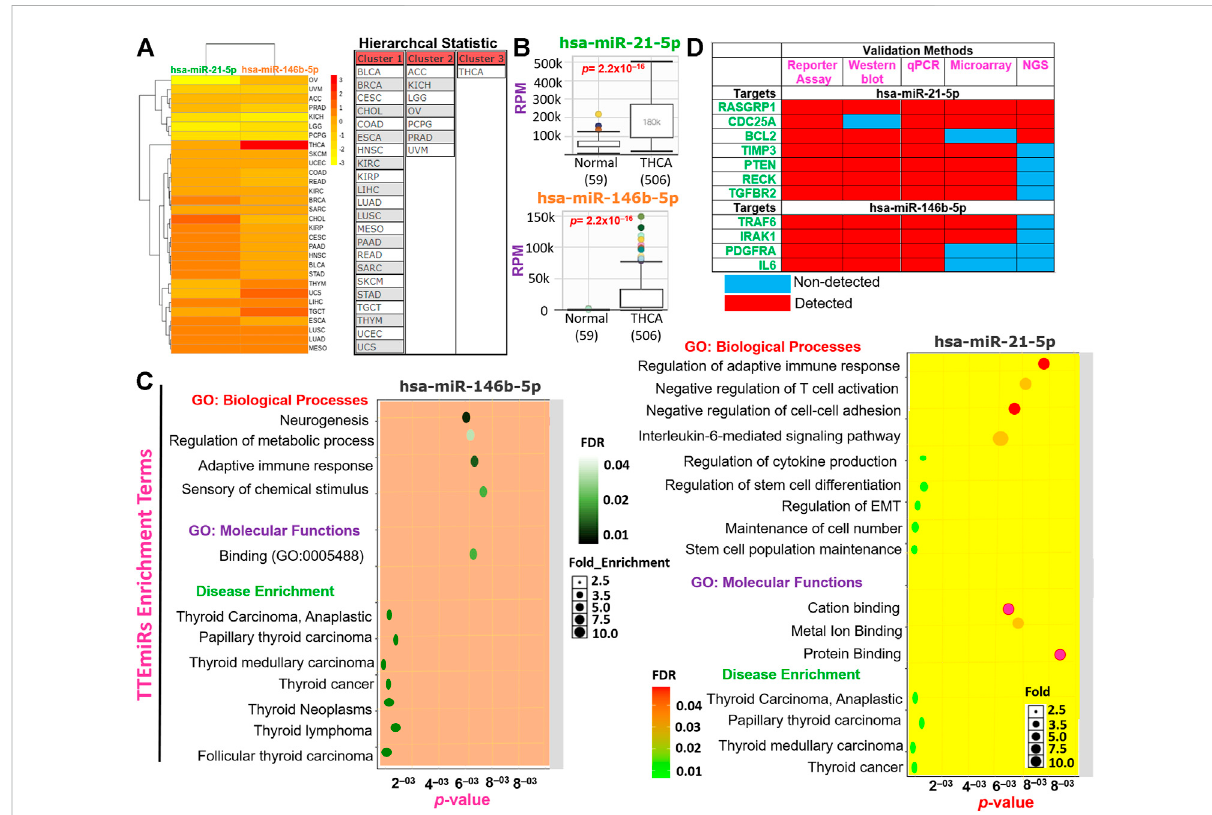
FIGURE 8 Thyroid tumor-enriched microRNA (TTEmiRs) are THCA-speci fi c oncogenic microRNA (miRs) that modulate the immune response, EMT, cell – cell adhesion to promote cell growth, and stem cell population. (A) Heatmap plot and hierarchal clustering of the TTEmiRs in TCGA cancer cohorts. (B) Bar plots showing the differential expression levels of the TTEmiRs between TCGA-THCA tumor and adjacent normal tissue and (C) enrichment plots of the TTEmiRs. (D) Plots of the TTEmiRs target genes based on experimentally validated protocols (D)